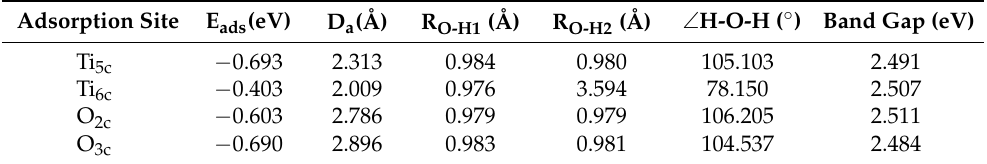
Table 2. Geometrical and electronic parameters of H 2 O-adsorbed models with various adsorption sites: adsorption energy (E ads ), adsorption length (D a ), defined as the length between the gas molecules and the nearest atom on anatase TiO 2 (101) surface, bond length (R O-H1 and R O-H2 ), bond angle ( ∠ H–O–H), and band